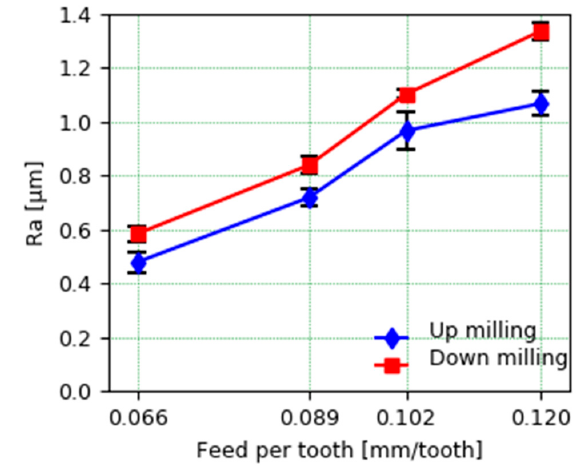
Figure 13. Average roughness (Ra) at different cutting strategies and feed per tooth.